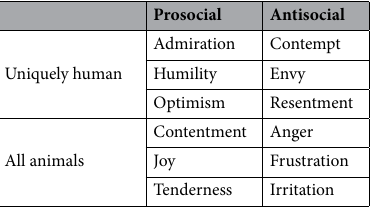
Table 2. Emotion terms included for each condition in Studies